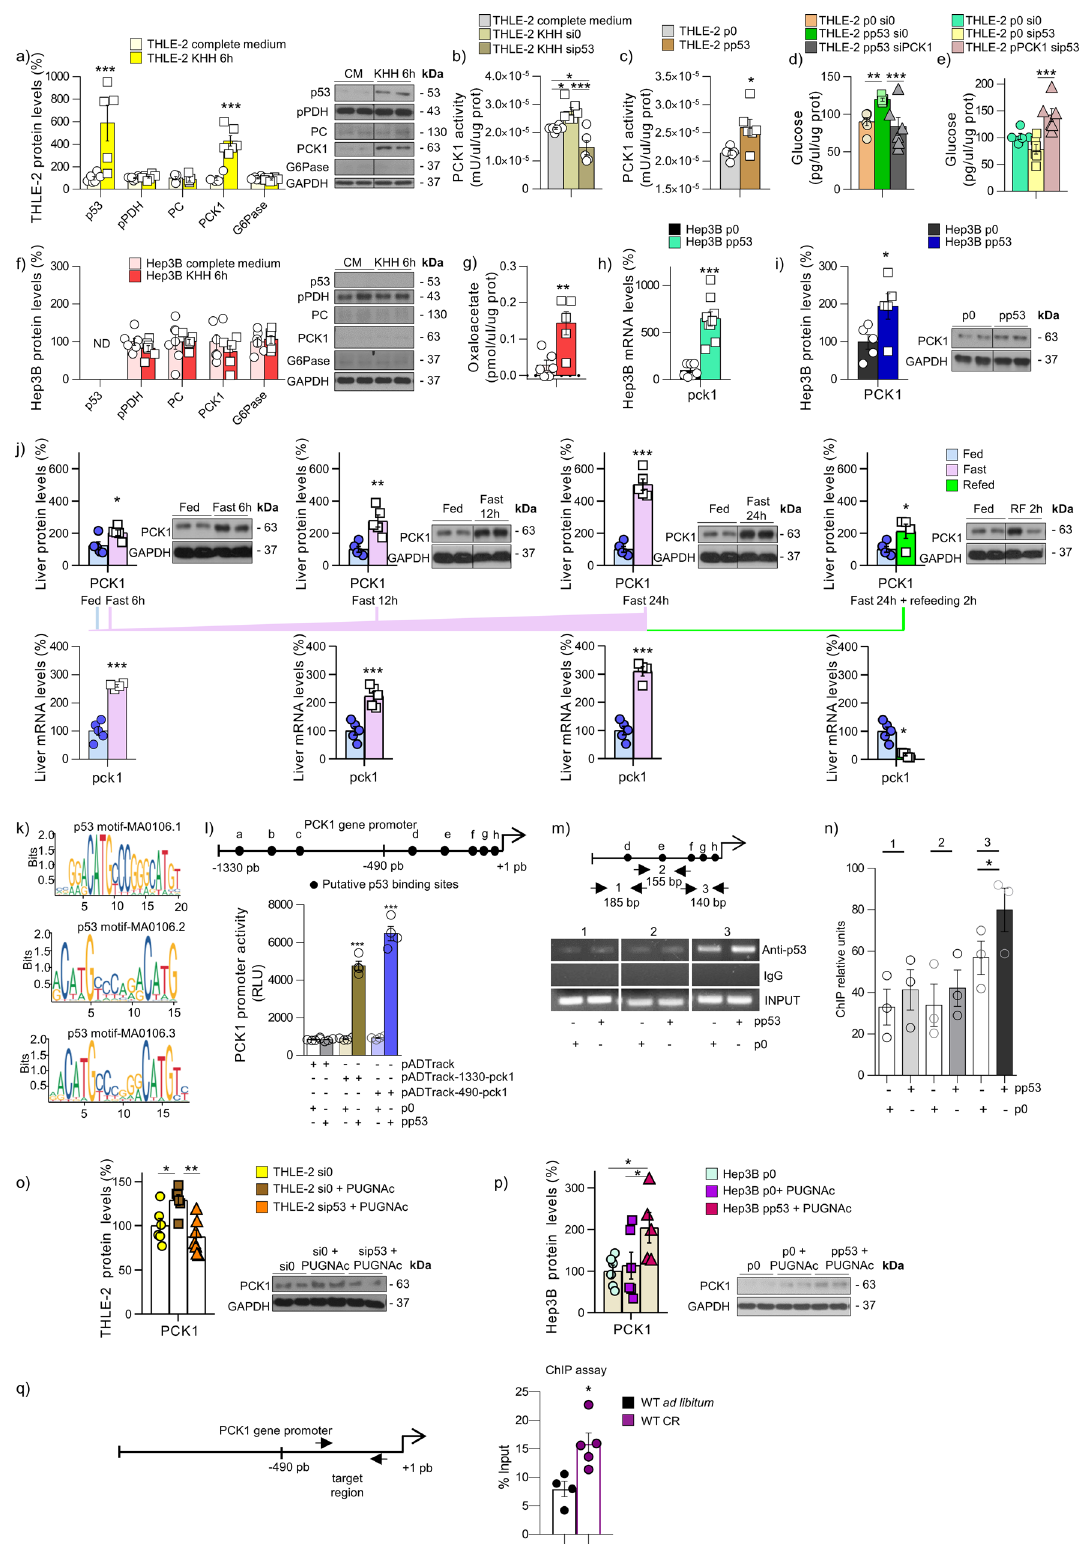
for 24 h (Fig. 3i). The inhibition of OGT downregulates protein levels of p53 and PCK1, as well as blood glucose levels when compared to control, fasted mice (Fig. 3j, k). In mice with a subsequent overexpression of p53 in the liver, we detect that p53 protein levels are increased (Fig. 3k). However, this overexpression